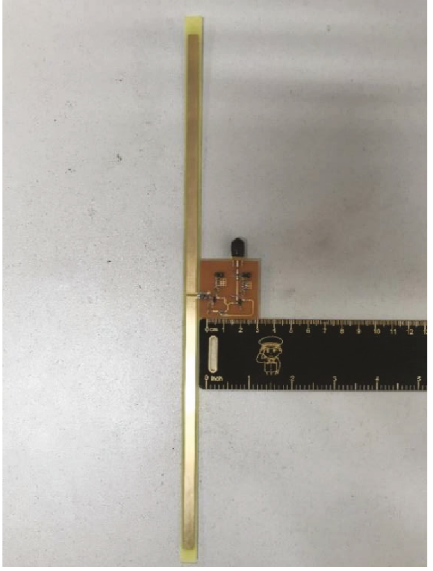
Figure 9: Fabricated NIC-loaded dipole.